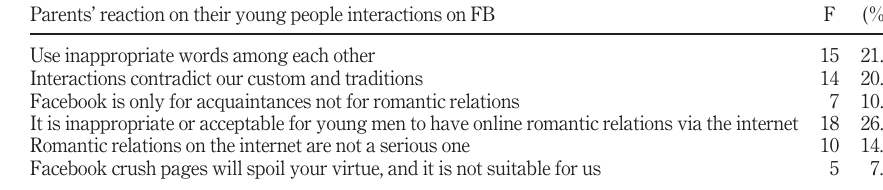
Parents ’ reaction on their young people interactions on